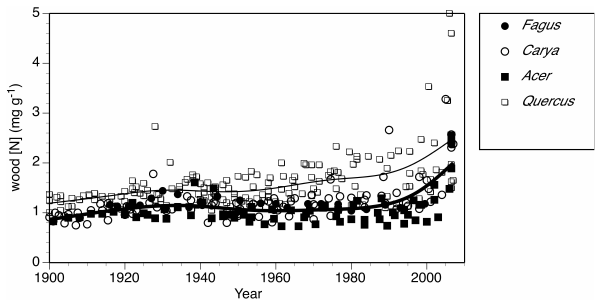
Fig. 3. Wood [N] over time. The thin line is a spline fit for Quercus wood, while the thick line is a spline fit for the three other hardwood